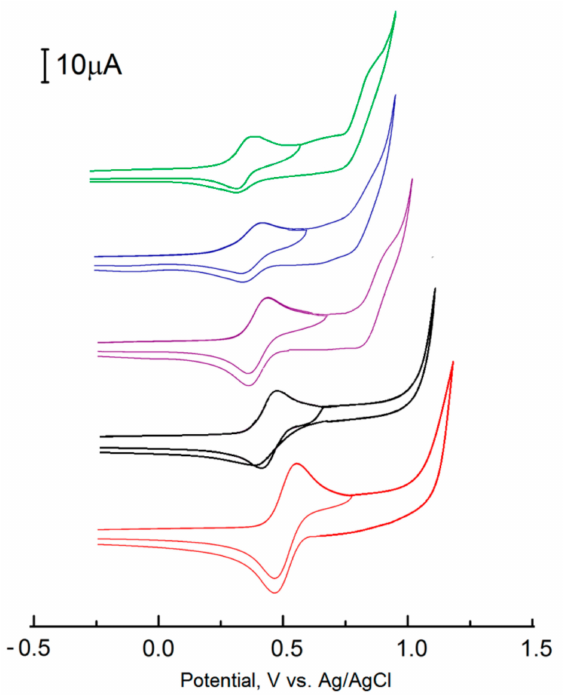
Figure 3. Cyclic voltammograms of 4a (red), 4b (green), 4c (blue), 4d (violet), and 4e (black) oxidation